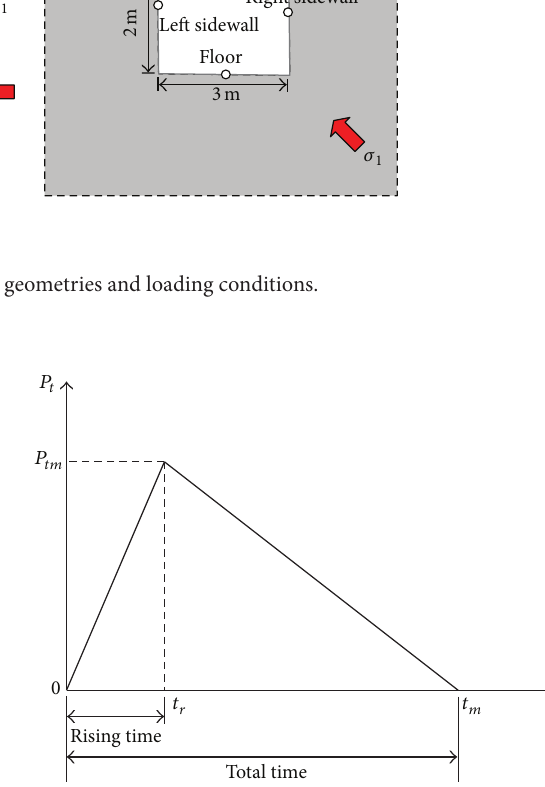
Figure 2: Triangle stress wave used as dynamic